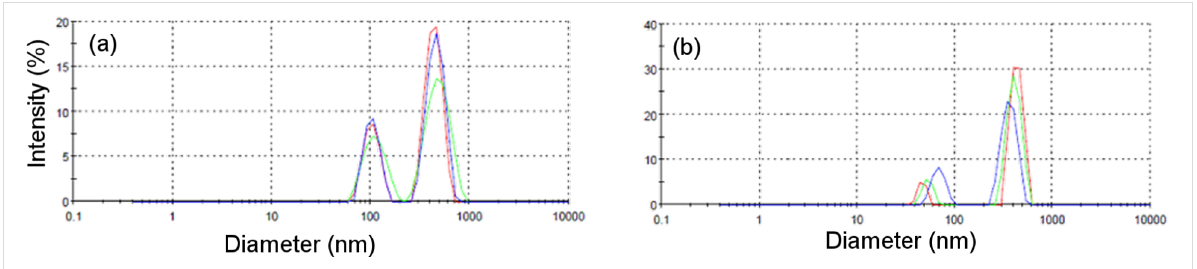
Figure 2: The size distribution profile of (a) Chl a –DPPC–MLVs (sample V1) and (b) Chl a –Chol–DPPC–MLVs (sample